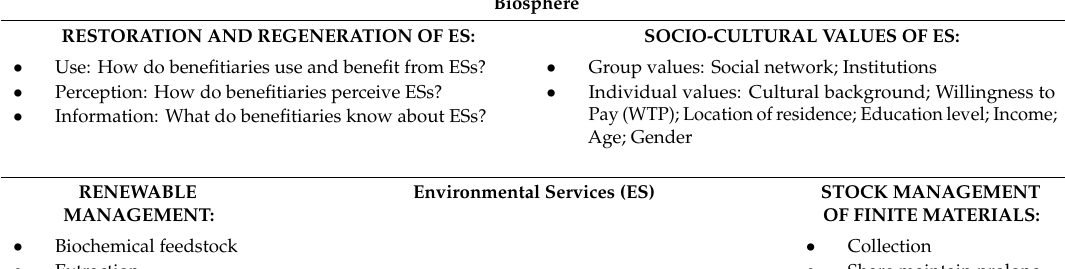
Table 4. Integrated biosphere–technosphere conceptual map implemented into inter-organizational grid. Sources adopted: [74], p. 5 / 20; [53], p. 69. Biosphere RESTORATION AND REGENERATION OF